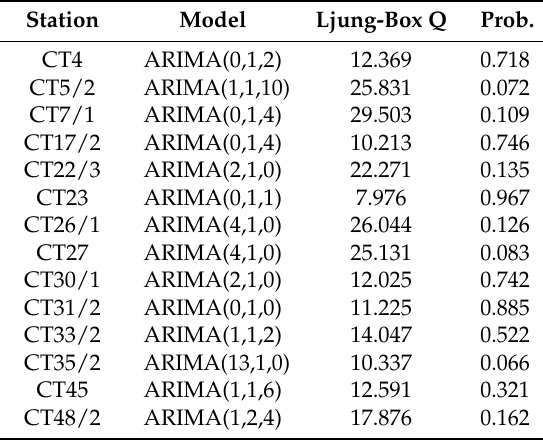
Table 7. Diagnostic checking of selected